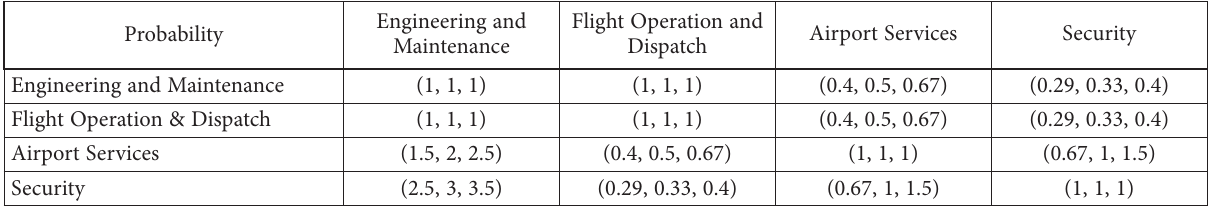
Table 3. Criteria comparison for all departments